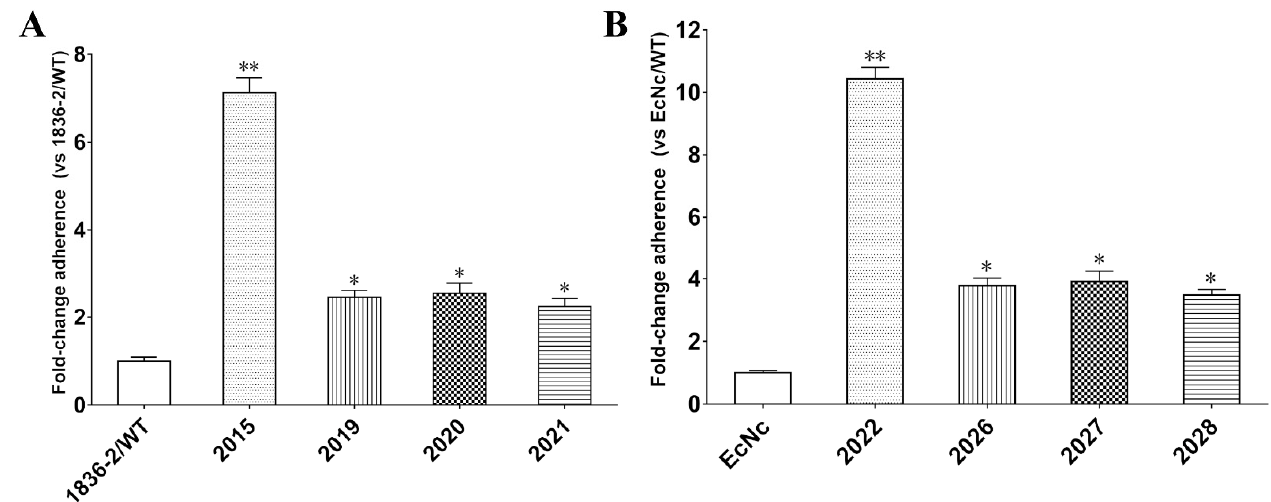
Figure 3. The ability of native LT or LTA mutants mediated E. coli 1836-2 and EcNc adhesion to intestinal epithelial cells. ( A ) Adhesion of ETEC 1836-2 expressed native LT (strain 2015) or LTA mutants (strains 2019, 2020, and 2021) to IPEC-J2 cells. The adhesion index of wild-type ETEC 1836-2 was assumed to be 100%. ( B ) Adhesion of E. coli EcNc expressed native LT (strain 2022) or LTA mutants (strains 2026, 2027, and 2028) to Caco-2 cells. The adhesion index of parent E. coli EcNc was assumed to be 100%. Data are expressed as mean ± SD of triplicate experiments. * indicates p < 0.05 and is deemed statistically significant. ** indicates p < 0.01 and is deemed statistically highly significant.